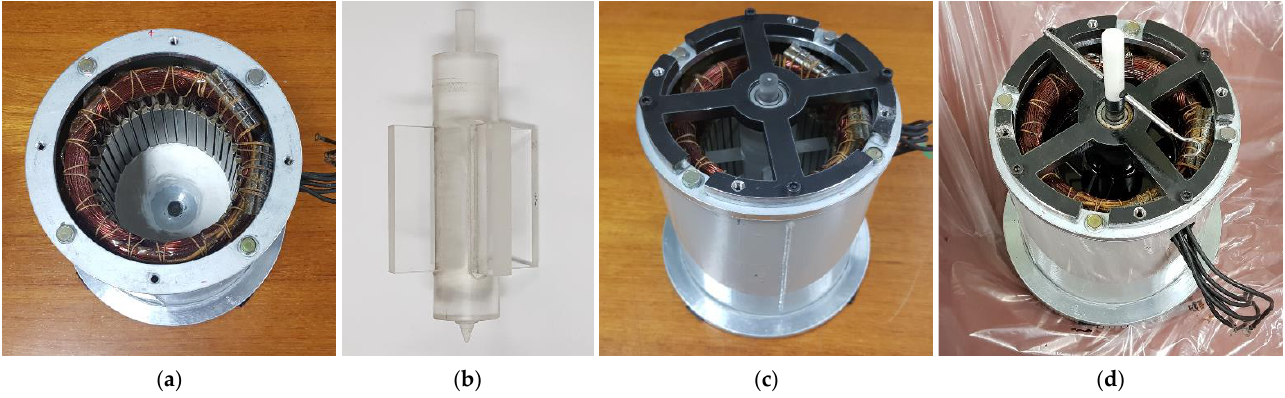
Figure 4. Experimental motor: ( a ) stator; ( b ) nonmagnetic rotor; ( c ) experimental motor without magnetic fluid; ( d ) filled with magnetic fluid.